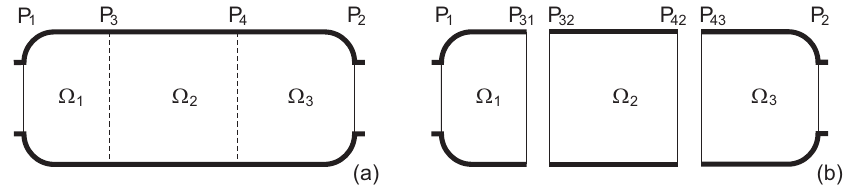
Figure 1. A source-free domain Ω with external ports P 1 , P 2 and internal ports P 3 , P 4 interfacing subdomains Ω 1 , Ω 2 , Ω 3 ( a ). Partitioning of Ω into separate subdomains bounded by split internal ports P 3 → { P 31 , P 32 } and P 4 → { P 42 , P 43 } ( b